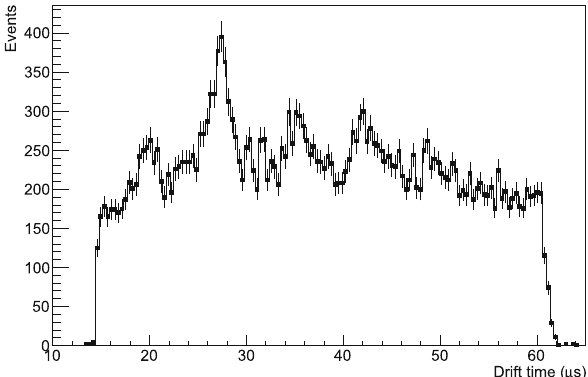
Fig. 10 Drift time distribution for an 241 Am calibration run taken at = 183 V/cm. The valleys in the distribution are due to the presence E d of the copper field-shaping rings and are reproduced by MC simulation